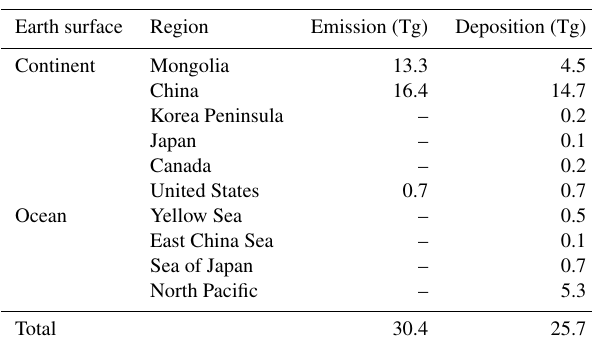
Table 3. Estimates of atmospheric dust emission and deposition over the Asian-Pacific region during 2–10 May